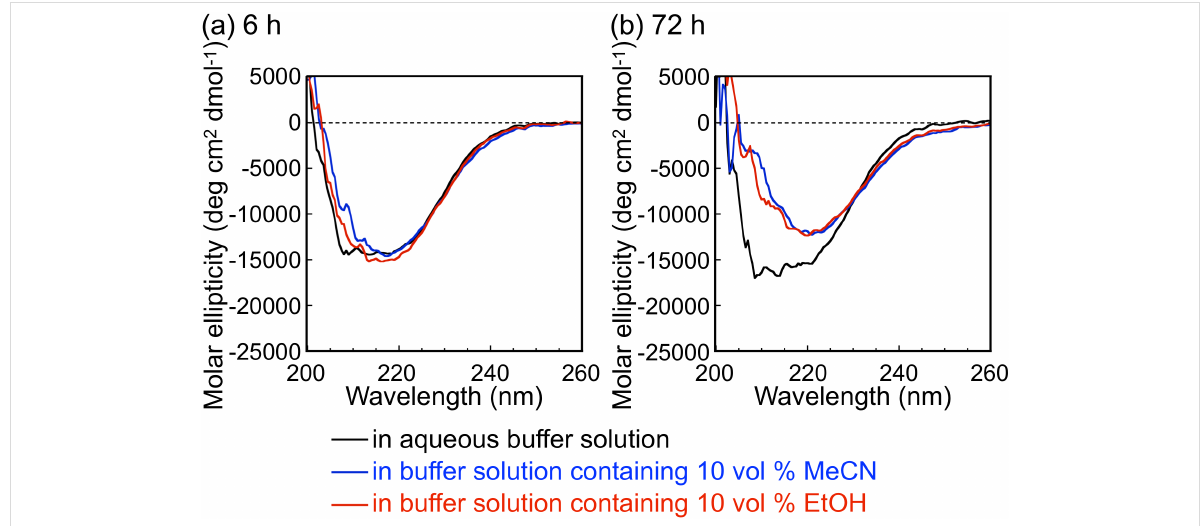
Figure 4: CD spectra of CDP in 8 mM phosphate buffer solution containing 10 vol % MeCN or EtOH after incubation at 60 °C for (a) 6 and (b) 72 h.